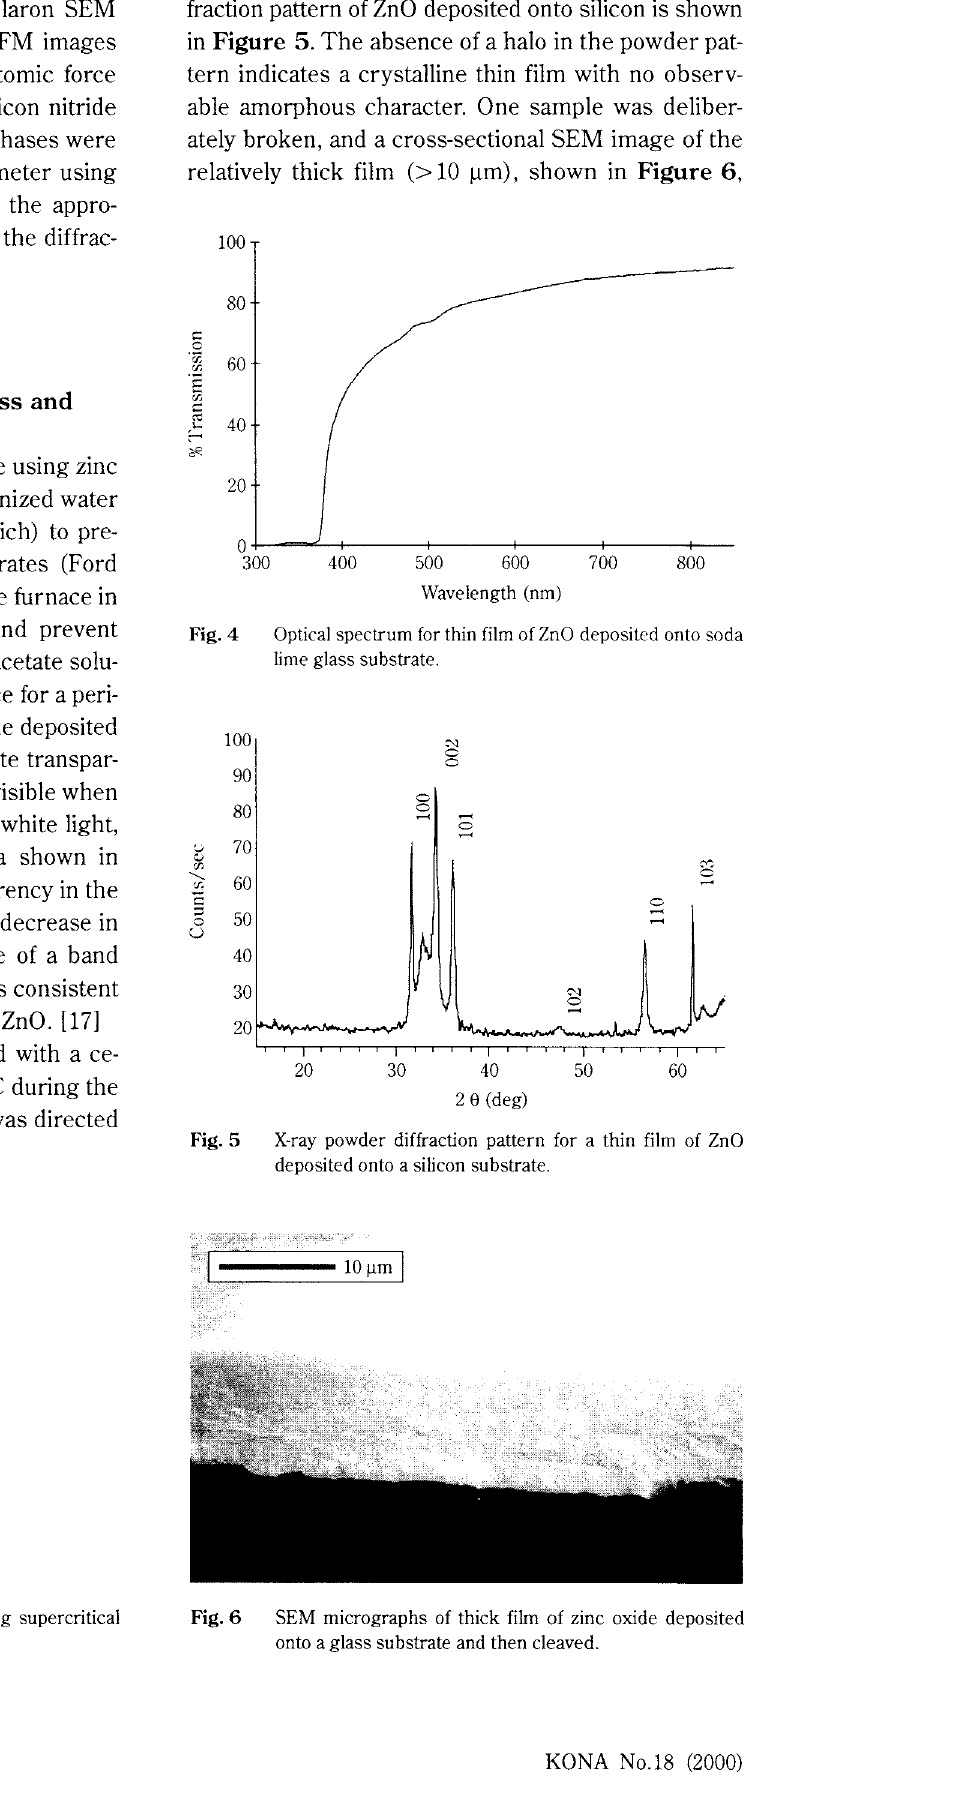
SEM micrographs of thick film of zinc oxide deposited onto a glass substrate and then